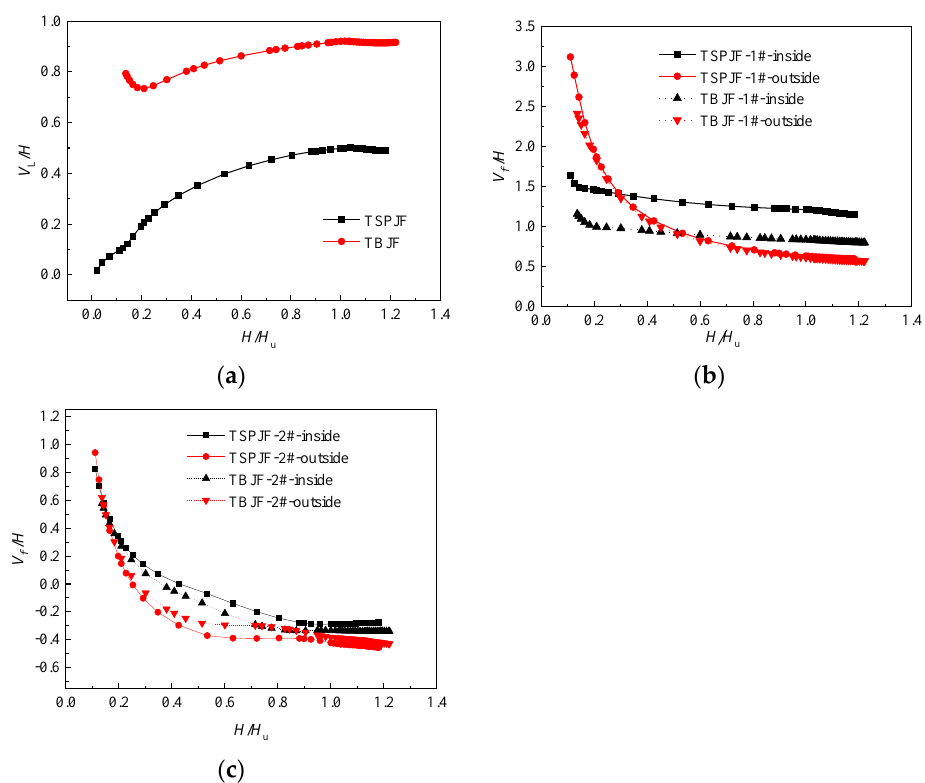
Figure 15. Vertical resistance of each part of the foundations at different horizontal loads. ( a ) lid resistance of 1# bucket, ( b ) frictional resistance of 1# bucket, ( c ) frictional resistance of 2# bucket.